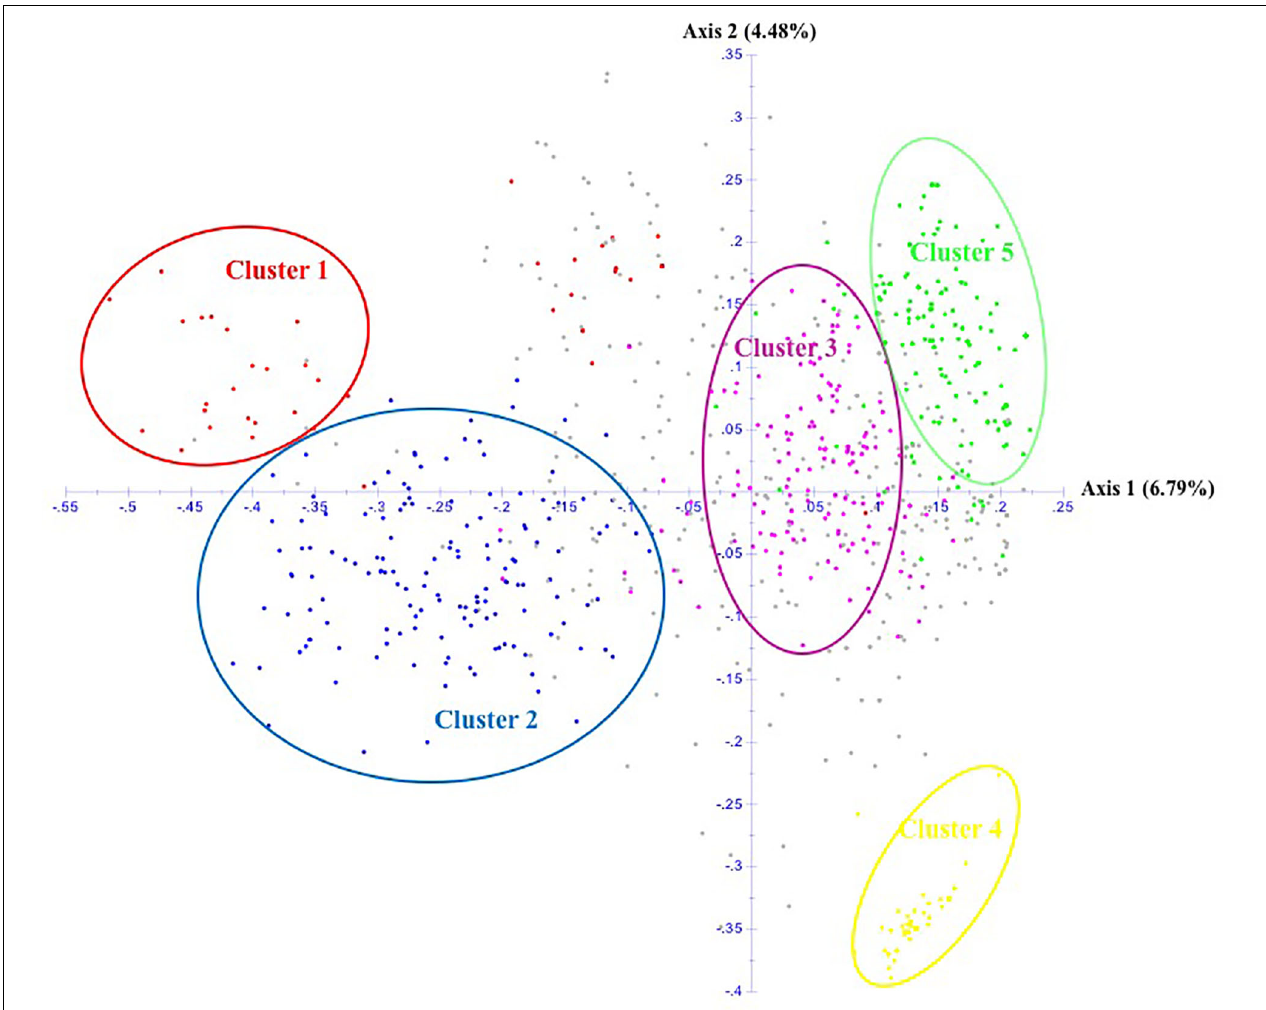
FIGURE 3 | Scatter plot of the Principal Coordinate Analysis of 890 apricot accessions based on 25 SSRs. The five clusters are depicted using the color codes as defined by STRUCTURE analysis with Cluster 1 in red, Cluster 2 in blue, Cluster 3 in pink, Cluster 4 in yellow, and Cluster 5 in green. The mixed accessions are in